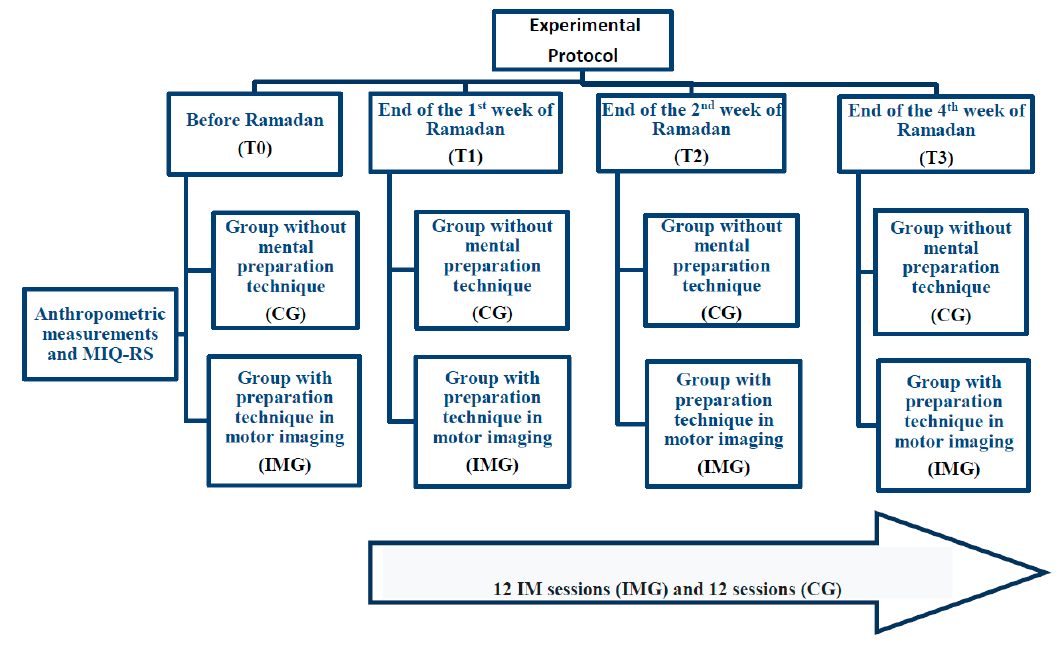
Figure 1. Experimental protocol adopted in the present study. Note. IMG = imagery training group; CG = control group; MIQ-RS = Motion Imagery Questionnaire.